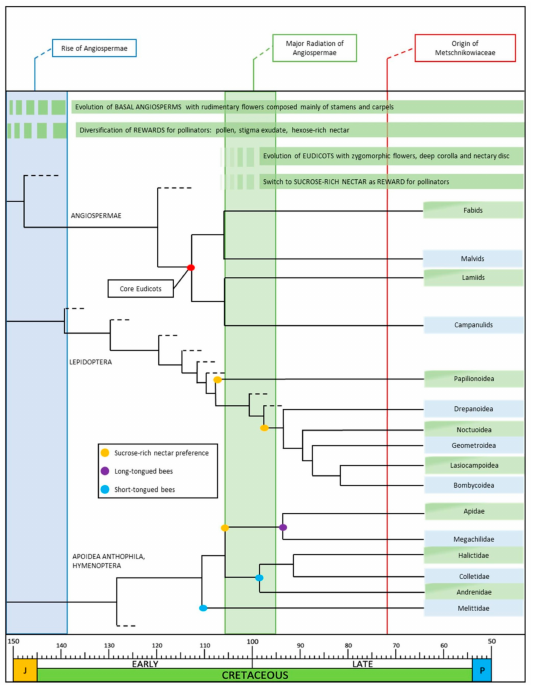
Figure 1. Annotated phylogeny of Angiosperms, Lepidoptera, and Hymenoptera summarizing the timing of evolution of principal traits involved in nectar-mediated flower–pollinator relationship. Dashed lines indicate non-eudicots clades or insect clades without sucrose-rich nectar preference. Phylogenetic data were obtained from